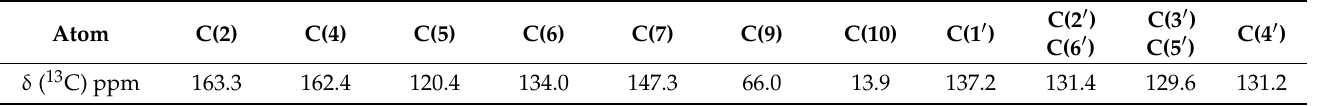
Table 2. 13 C Chemical shifts of 5a in CDCl 3 (100